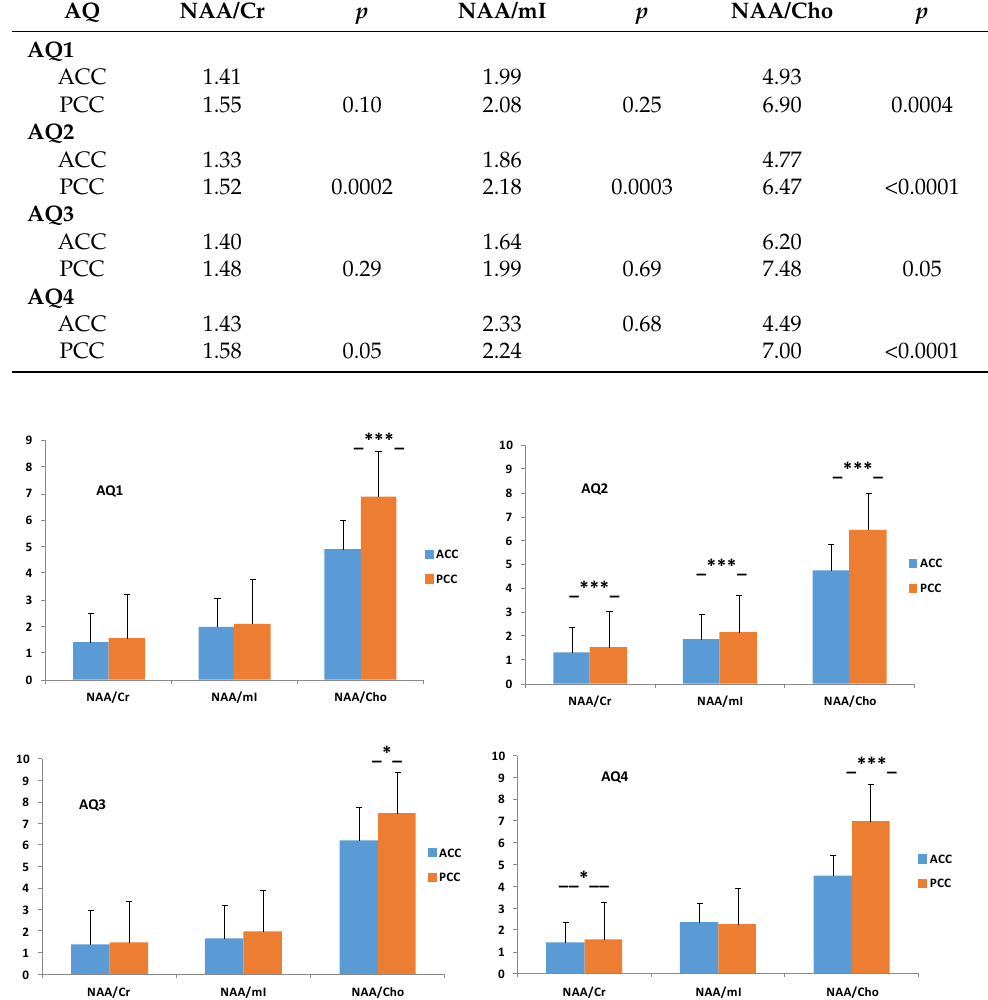
Figure 3. Differences in the means of the NAA/Cr, NAA/mI, and NAA/Cho ratios between the ACC and PCC in the AQ1 (28.3%; n = 17), AQ2 (43.3%; n = 26), AQ3 (10.0%; n = 9), and AQ4 (18.3%; n = 13) groups. The AQ1 group was taken as a reference or control. p < 0.05 considered significantly different. -*-, -***-, significant at p < 0.05, 0.001, respectively.